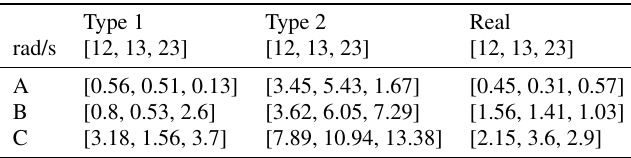
Table 1: The angular velocity variations for the simulated and the real IMU measurements: 12 represents the variation between the first and the second DOF for each IMU A, B, C. Each num- ber expresses the mean of squared differences between the simu- lated/measured angular velocities for all the timesteps.